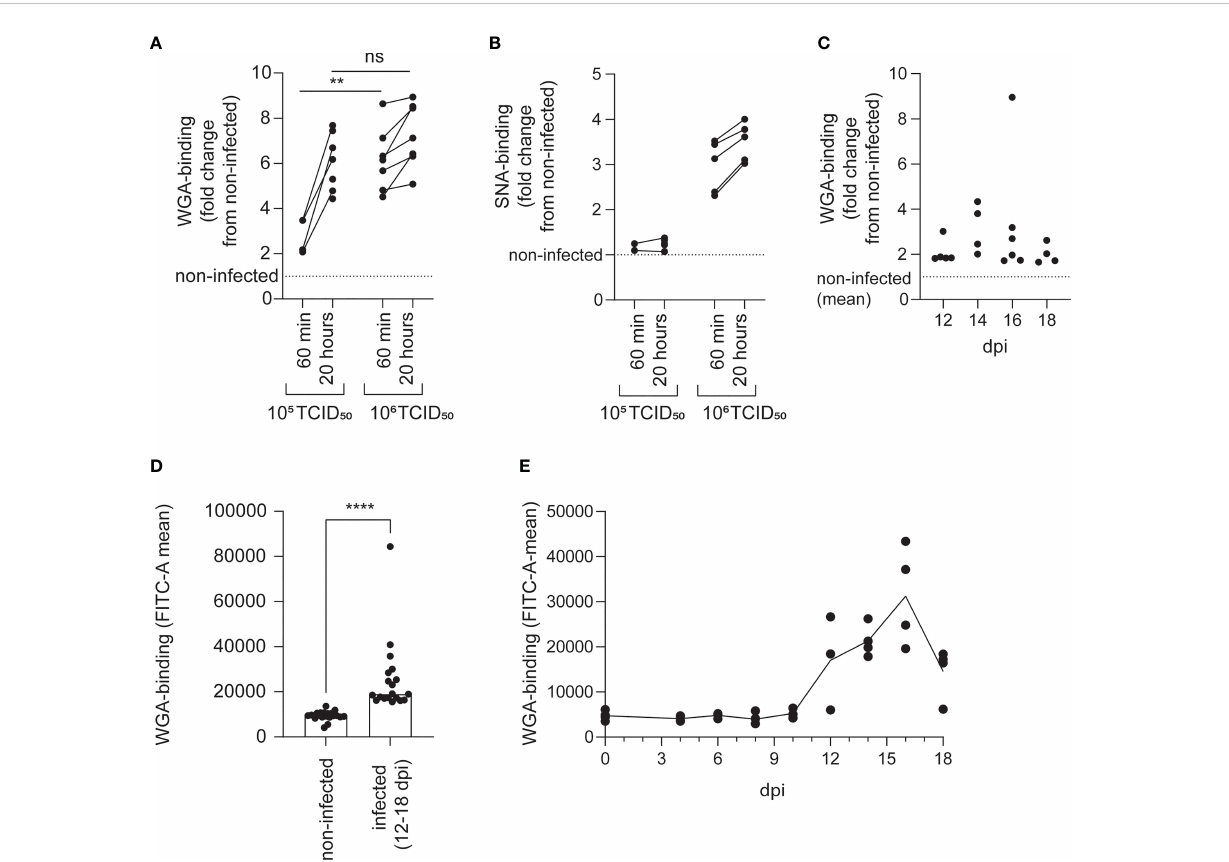
FIGURE 4 The loss of ISAV binding is accompanied by increased availability to sialic acid-binding lectins. The lectin-binding capacity of erythrocytes was evaluated by fl ow cytometry. (A, B) Density-puri fi ed erythrocytes isolated from non-infected fi sh were incubated with ISAV at the indicated dose (per 20 million cells) and given duration, and WGA-binding (A) and SNA-binding (B) was quanti fi ed in live cells by fl ow cytometry. Data points show measurements in cells from individual fi sh, with lines connecting values from the same fi sh. ** p < 0.01, Mann-Whitney U, ns, non-signi fi cant. (C, D) WGA-binding to